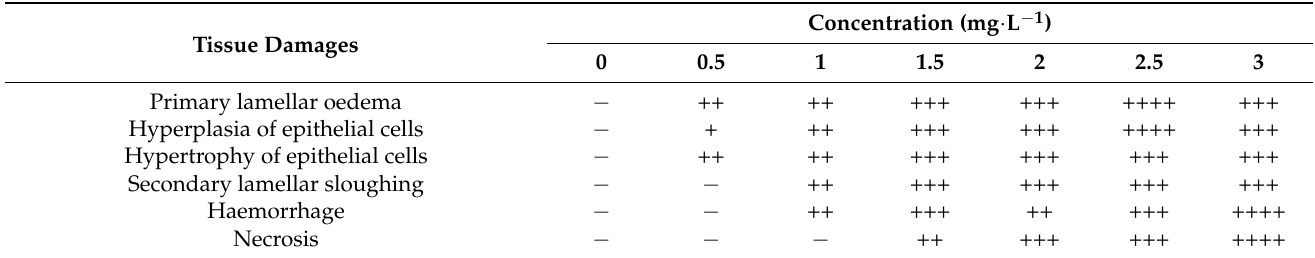
Figure 3. The different tissue damage to the gills of fish exposed to different concentrations of DZN: ( a ) Fish gill lamellae exposed to 1 mg · L − 1 DZN after 96 h (H&E, 40 × ), exhibiting primary lamellar oedema (yellow arrow). ( b ) Exposure to 1.5 mg · L − 1 DZN after 96 h (H&E, 40 × ), displaying hyperplasia of secondary lamellae (yellow arrow). ( c ) Exposure to 1.5 mg · L − 1 DZN after 96 h (H&E, 10 × ), indicating hypertrophy (HT) and primary lamellar oedema ( * ). ( d ) Exposure to 2 mg · L − 1 DZN after 96 h (H&E, 10 × ), revealing haemorrhage (HR) and secondary lamellar shortening (N). ( e ) Exposure to 2.5 mg · L − 1 DZN after 96 h (H&E, 10 × ), depicting secondary lamellar sloughing (SLA) and hypertrophy (HT). ( f ) Exposure to 3 mg · L − 1 DZN after 96 h (H&E, 10 × ), illustrating necrosis (white arrow) and haemorrhage (HR). Table 3. Gill histopathology in grass carp ( Ctenopharyngodon idella ) after exposure to different con- centrations of diazinon (DZN).